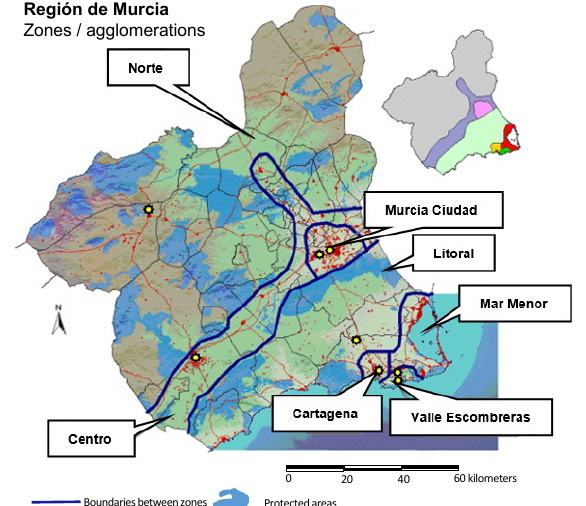
Figure 1. Zones of Región de Murcia, Spain (https://sinqlair.carm.es/calidadaire/ (accessed on 26 November 2022 )). Yellow dots represent the air quality monitoring